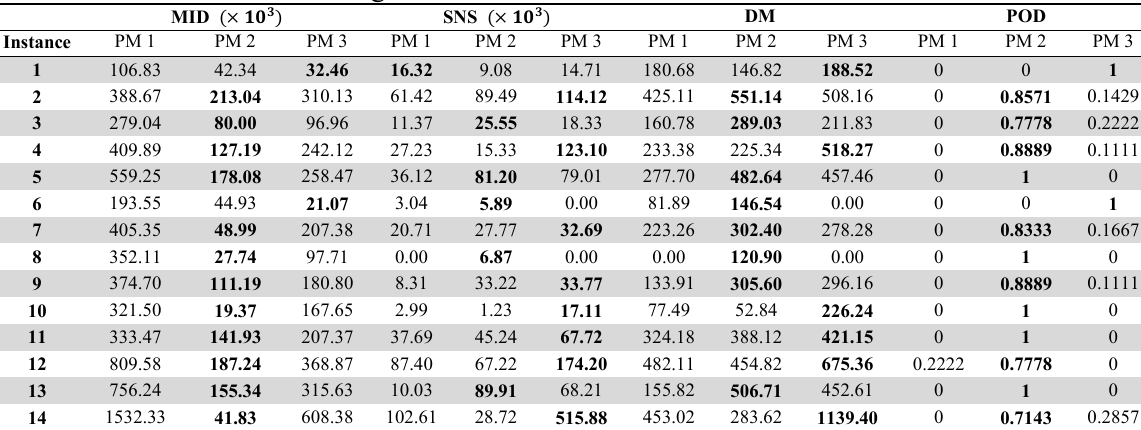
Performance metrics for each